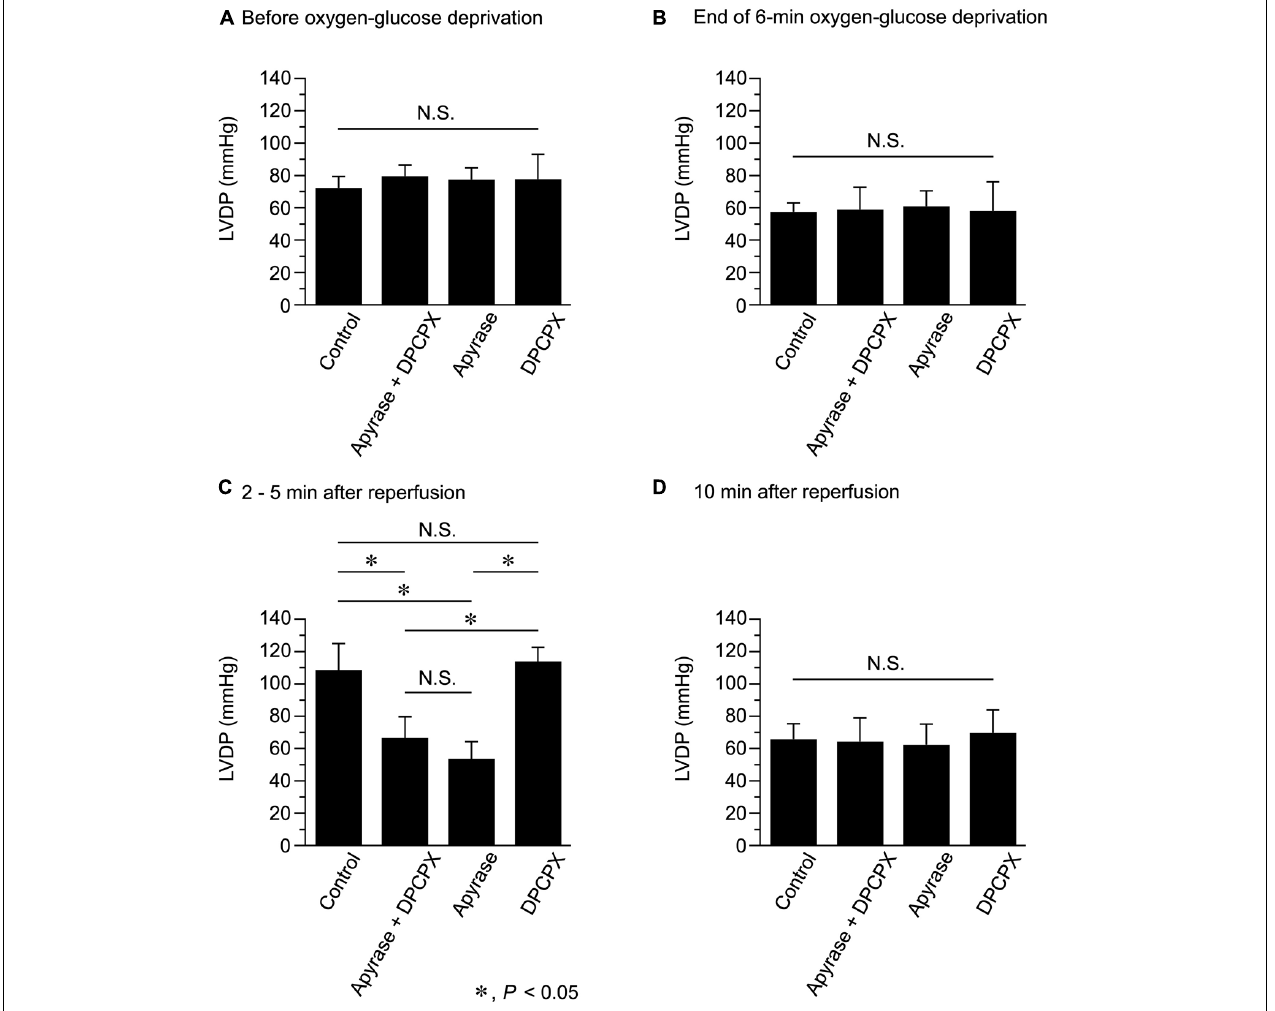
FIGURE 3 | Effects of apyrase and DPCPX added together or separately to the perfusion medium on left ventricular developed pressure (LVDP), measured before (A) and at the end of 6-min oxygen-glucose deprivation (B) , and at 2–5 min (C) and 10 min (D) after reperfusion ( n = 4 for each group; using 16 mice in total). * P < 0.05; N.S. = not